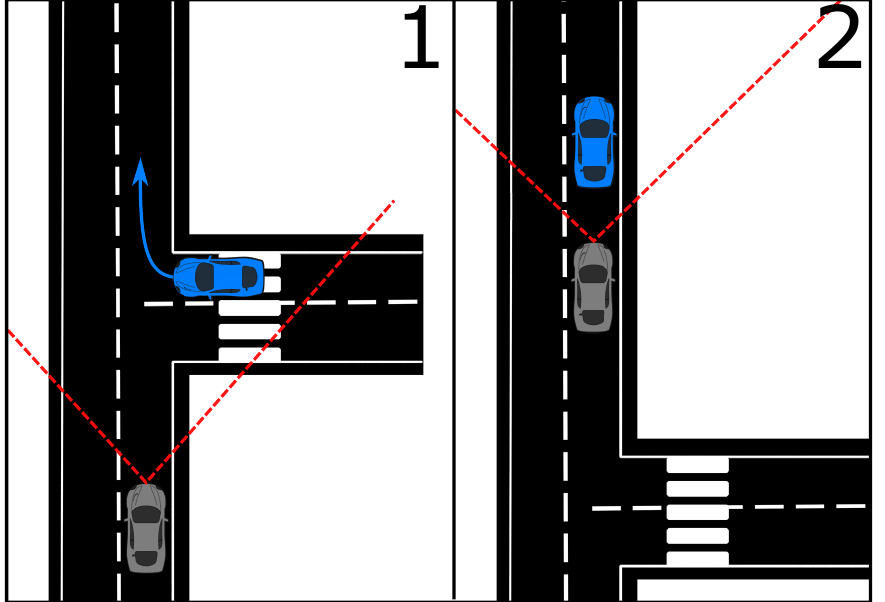
Figure 6. An example of a situation on the road when the late first detection can correspond to omitting a crucial event during the whole appearance of the object. 1—The initial maneuver of joining the traffic of an object. 2—Following the object. Our tracking evaluation approach is constructed to indicate this situation and emphasize it